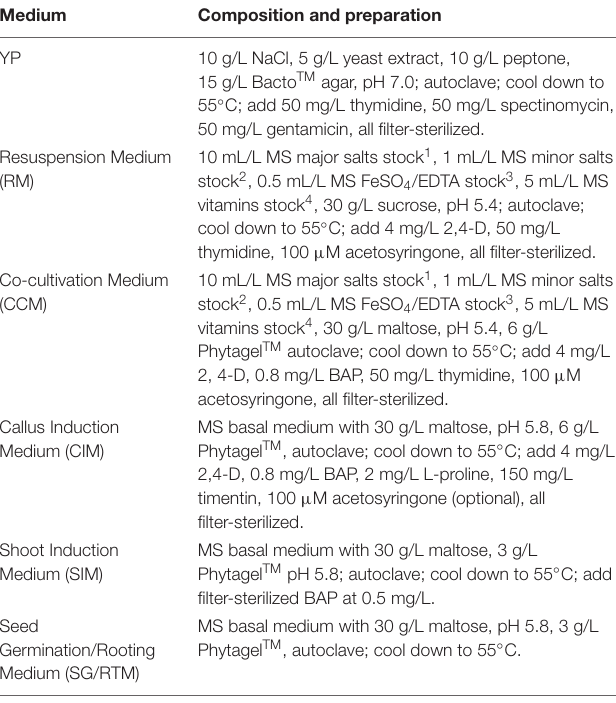
TABLE 1 | Composition and preparation of media used in the experiments (modified based on Li et al., 2015).